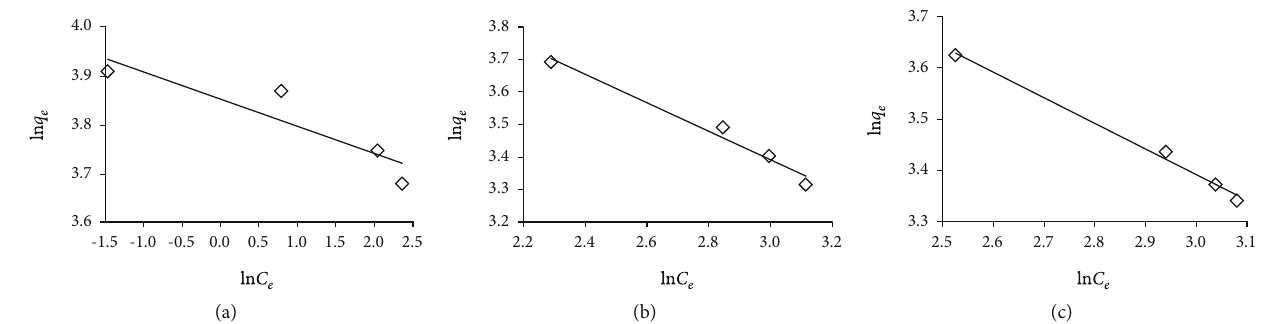
Figure 18: Freundlich adsorption isotherms for adsorption of (a) Pb (II), (b) Cr (III), and (c) Cd (II) on amidoxime chelating resin, pH5, and temperature at 25 °